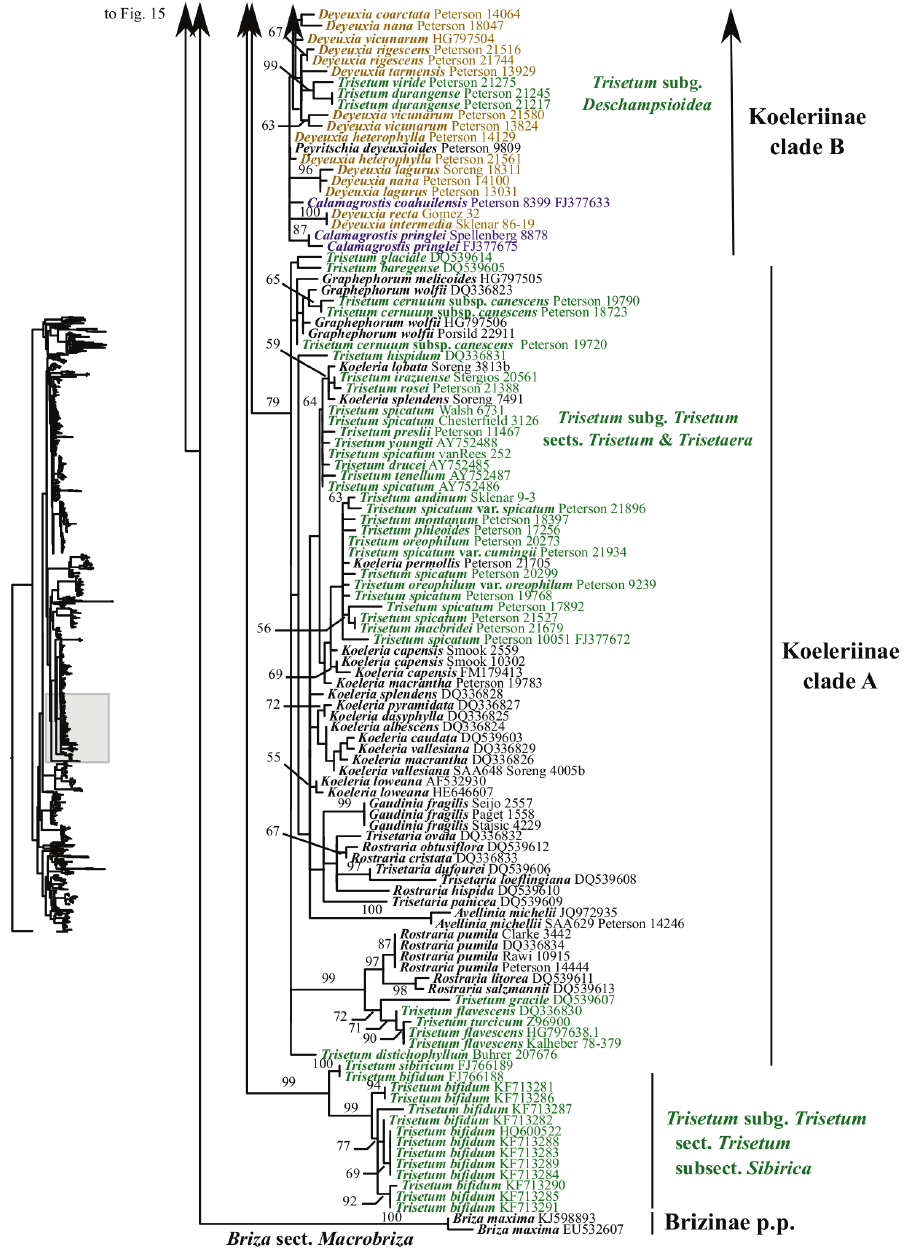
Figure 16. A portion (Koeleriinae clade A, part of Koeleriinae clade B, Trisetum subsect. Sibirica and Brizinae p.p.) of the maximum likelihood phylogram inferred from ITS data. ML bootstrap support is recorded along branches when >50%. The shaded area of the smaller tree on the left indicates the location in the overall tree of the portion